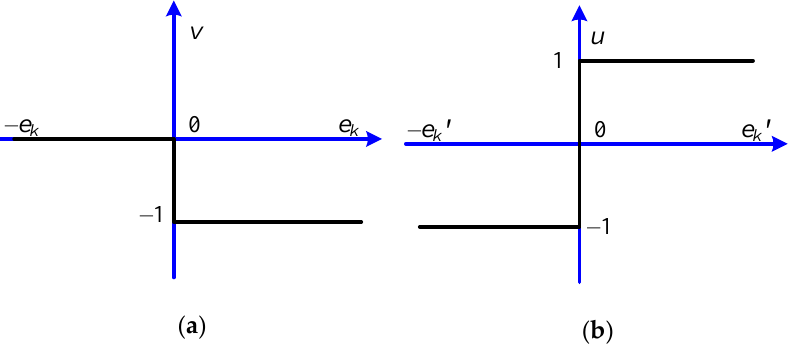
Figure 3. Ideal functions u and v of the proposed AAVE method. ( a ) function v ; ( b ) function u .